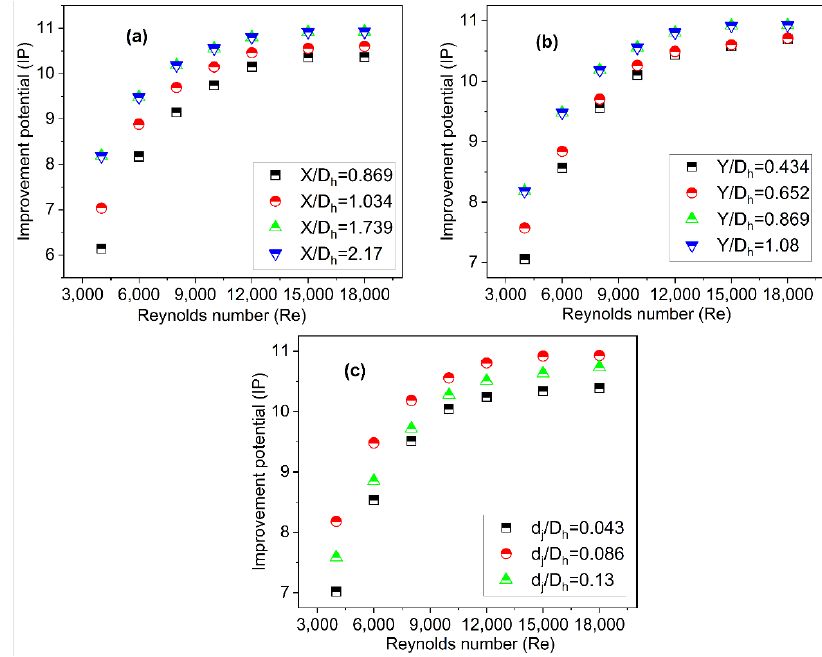
Figure 19. Improvement potential ( IP ) variation for ( a ) X/D h , ( b ) Y/D h and ( c ) d j /D h